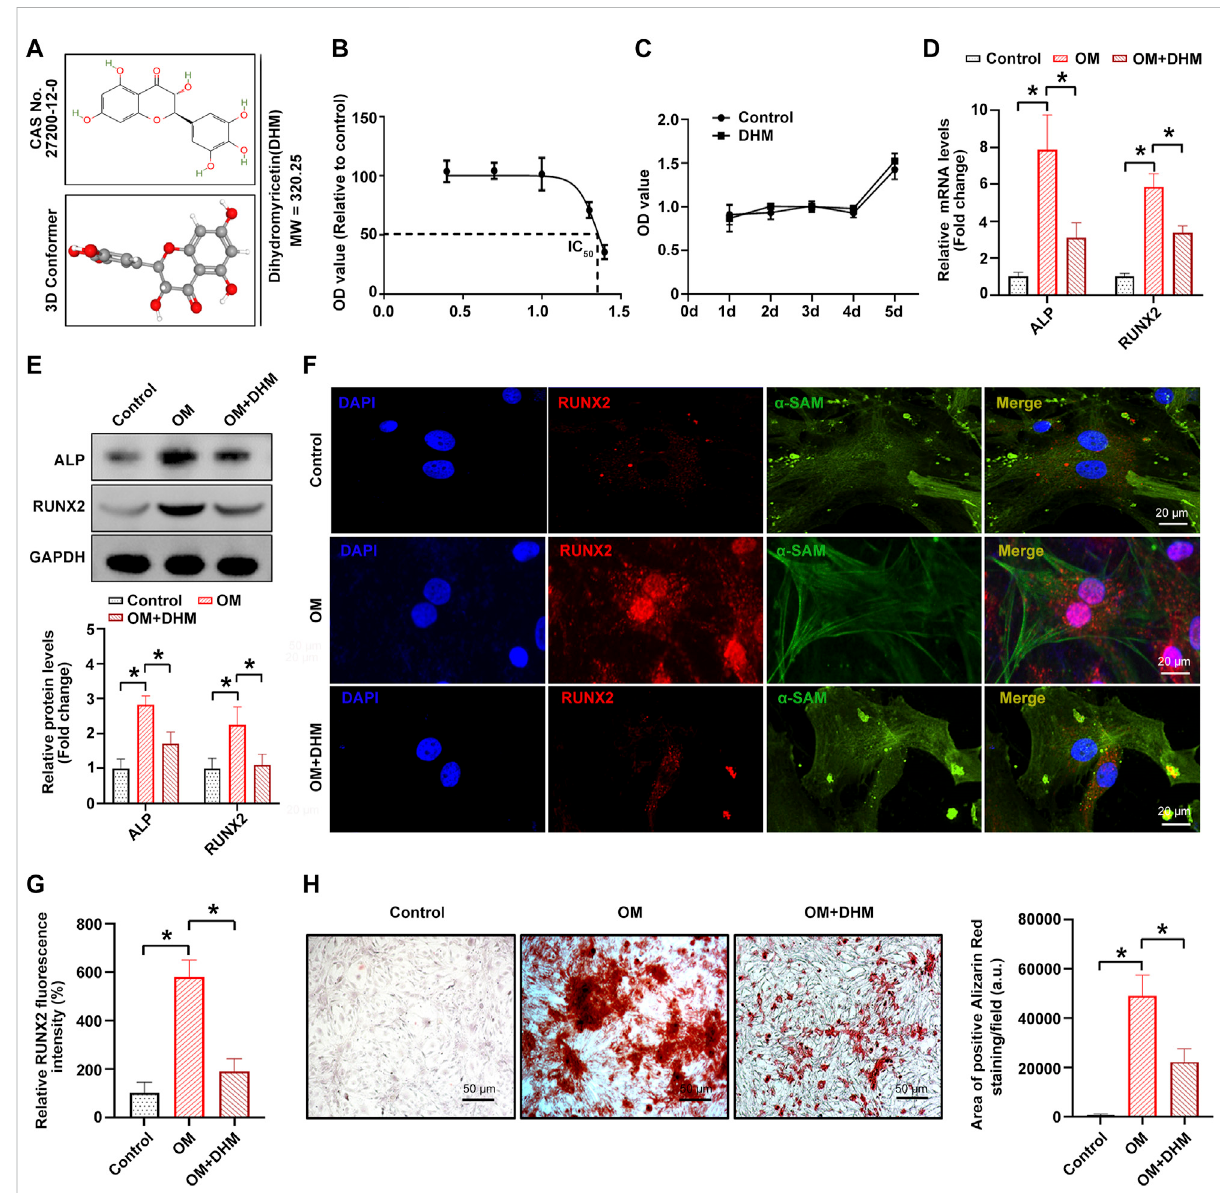
Dihydromyricetin (DHM) inhibits osteogenic differentiation of human valvular interstitial cells (hVICs). (A) Molecular structure of DHM. (B) Half- maximal inhibitory concentration (IC 50 ) of DHM on hVICs; concentrations were transferred to Log (C) . (C) Cell Counting Kit-8 (CCK-8) assay was conducted todetect thecellproliferation rateofhVICswith theindicatedtreatmentfor5days.ThemRNA (D) andprotein (E) levelsofosteogenesis- speci fi c genes (alkaline phosphatase, ALP, and runt-related transcription factor 2, RUNX2) in hVICs stimulated with osteogenic induction medium (OM) and then treated with or without DHM. One-way ANOVA followed by Bonferroni post hoc test . Immuno fl uorescence staining (F) and semiquanti fi cation (G) of RUNX2 in hVICs stimulated with OM and then treated with or without DHM. One-way ANOVA followed by Bonferroni post hoc test . (H) Alizarin red staining of mineralization nodules in hVICs stimulated with OM and then treated with or without DHM. One-way ANOVA followed by a Bonferroni post hoc test . N = 3 per group. Values are the mean ± SD. * p < 0.05 indicates a signi fi cant